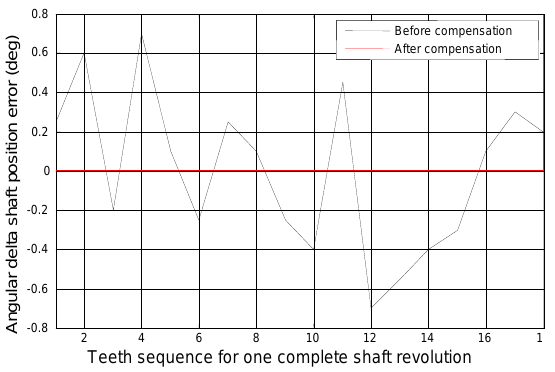
Figure 6. Angular delta shaft position error vector before- and after- compensation.